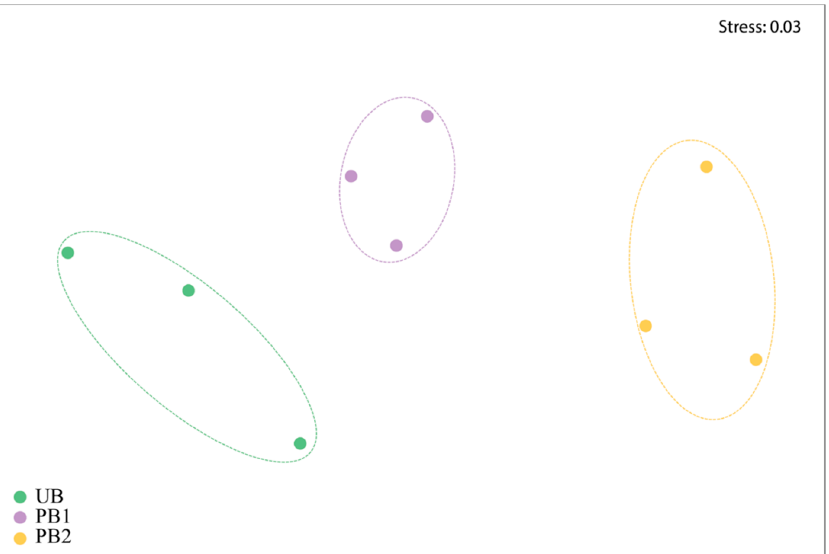
Figure 4. Non-metric multidimensional scaling (nMDS) ordination based on Bray–Curtis similarity, showing the bacterial community structures derived from relative abundance based on genus level across the different samples of burned (PB1 and PB2) and unburned soils (UB). The stress value denotes the goodness of fit. UB: unburned control soils; PB1: soils treated with prescribed burning seven months before sample collection; PB2: soils treated with prescribed burning immediately prior to sample